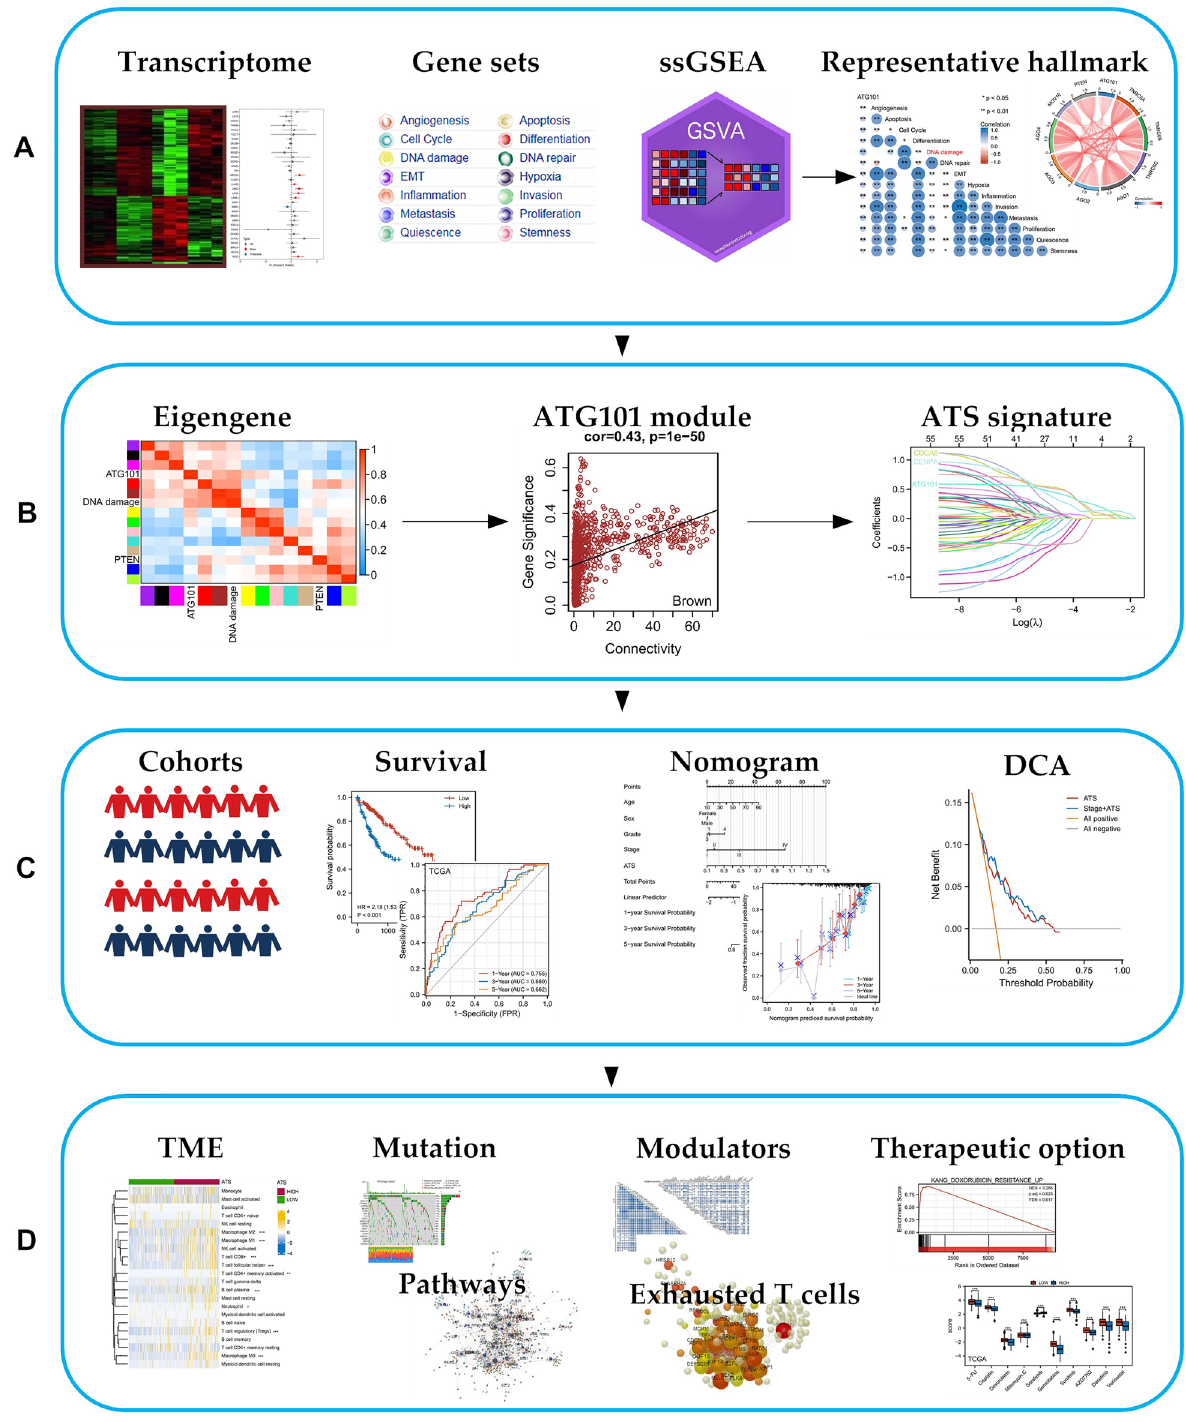
Figure 1. Schematic diagram of the study design. ( A ) A summary of the data sources used in the study to generate the gene signatures. ATG101 was identified as an oncogene in HCC after pan-cancer screening. ( B ) ATG101-related gene signature (ATS) was established using a combination of approaches, such as WGCNA and LASSO-Cox regression. ( C ) The performance of ATS was validated in external cohorts, using time-dependent receiver operating characteristic, nomogram and DCA. ( D ) Characterization of the feature of ATS, including its effect on TME, mutation profile, immunological properties and therapeutic